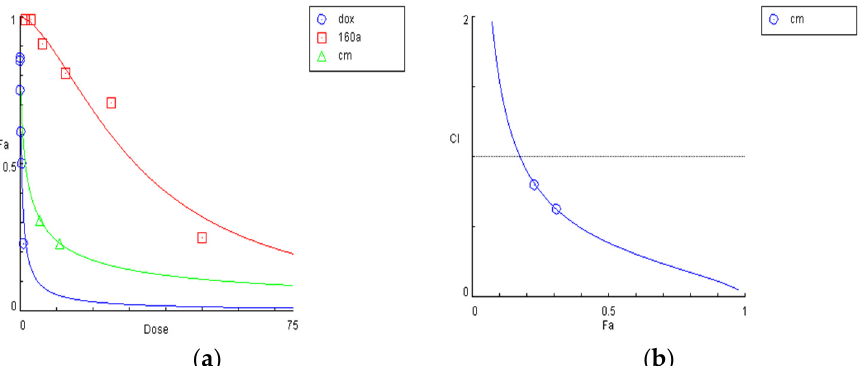
Figure 3. Analysis of the synergistic effect of compound 160a and doxorubicin on the dox-resistant cancer cell line A549/DOX using the CompuSyn program. ( a ) Dose–effect curve of compound 160a, doxorubicin, and compound 160a combined with doxorubicin versus relative MTS value; ( b ) Fa–CI plot (Chou–Talalay Plot). Fa, fraction of system affected; CI, combination index. CI = 1 indicates an additive effect; CI < 1 indicates synergism; CI > 1 indicates antagonism [25]. n = 3. Cm, combination; Dox, doxorubicin.